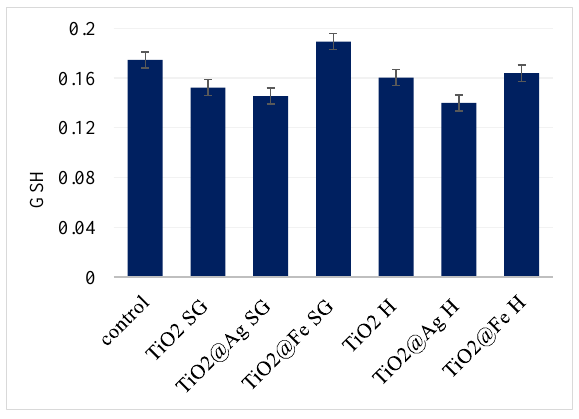
Figure 11. GSH analysis results for samples after 24 h.